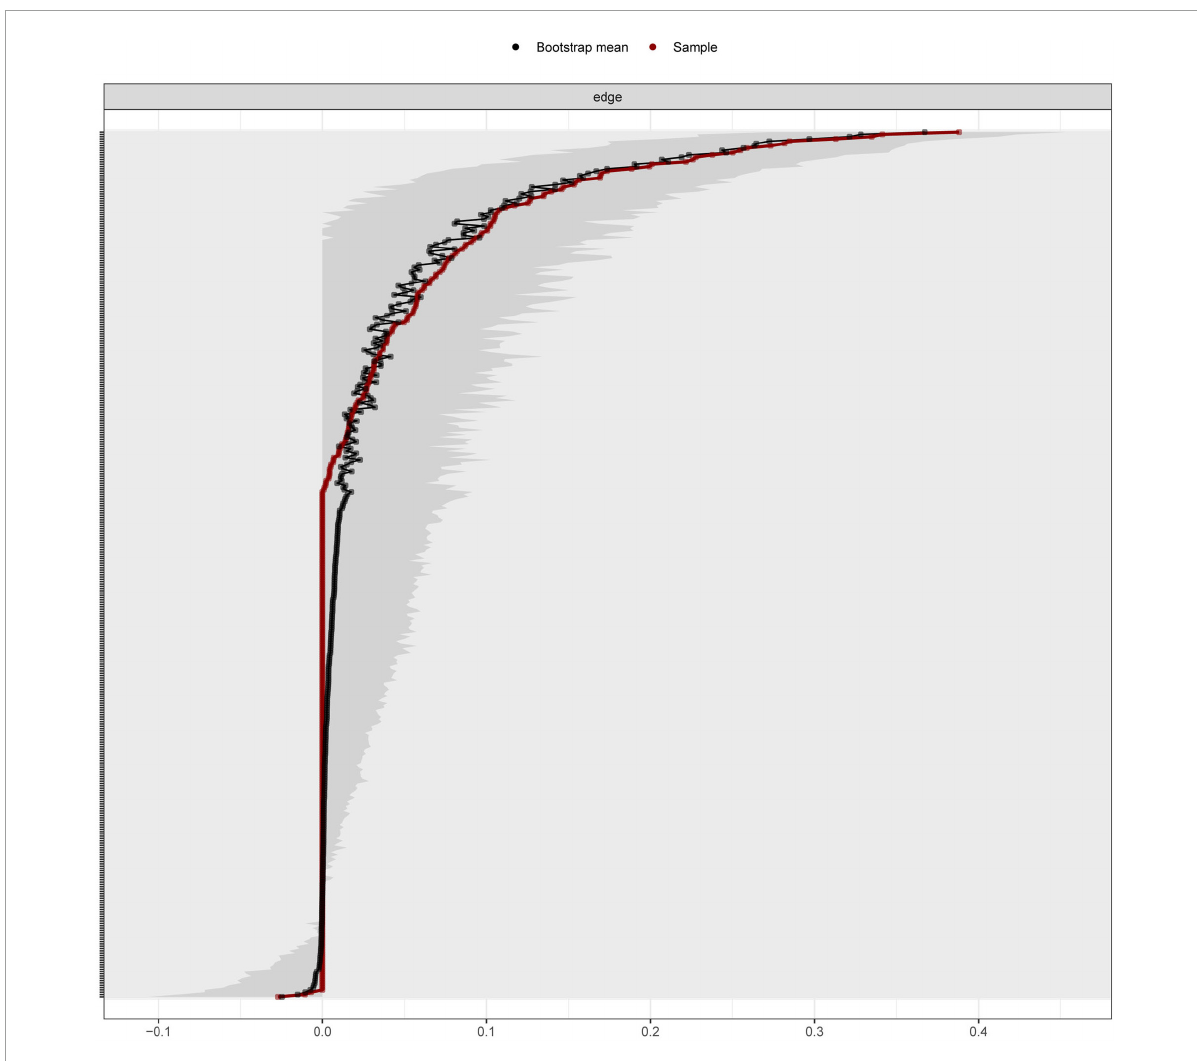
FIGURE4 The accuracy of edge weights. The red line indicates the sample values and the gray area indicates the bootstrapped CIs. The y-axis labels have been removed to avoid